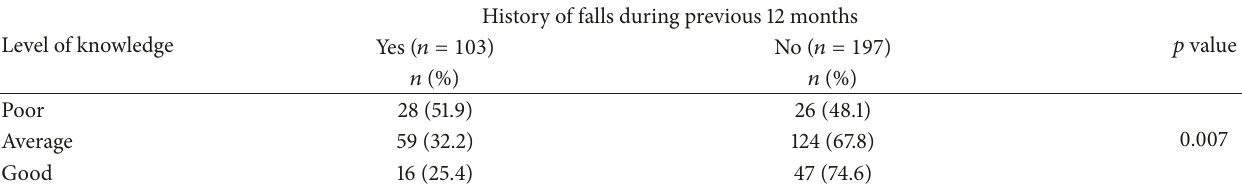
Table 4: Association of level of knowledge with history of falls ( 𝑛 = 300